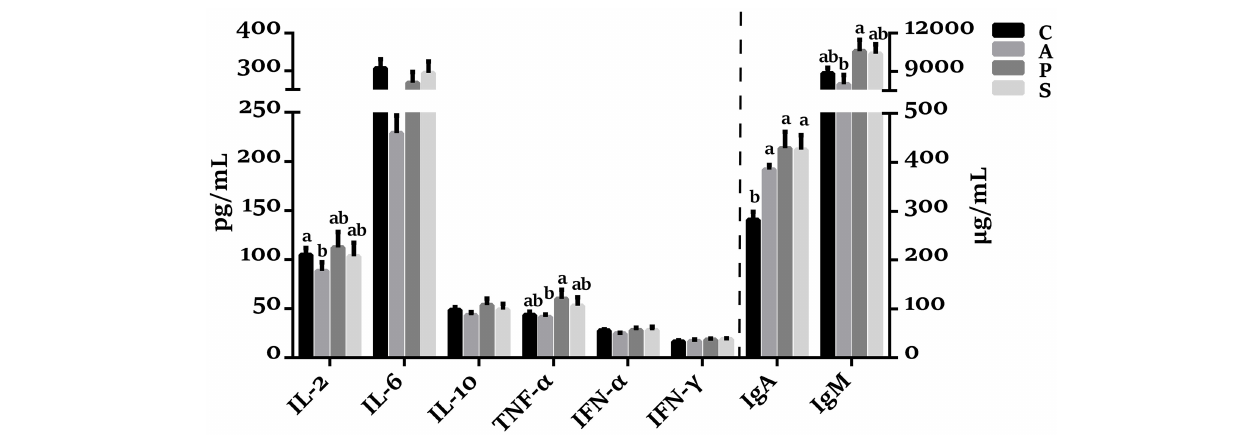
FIGURE 1 | Effects of maternal probiotic or synbiotic supplementation on the plasma cytokines concentrations of offspring piglets. Data are represented as means ± SEM, n = 8 per group. Different letters indicate significant differences among the groups ( P < 0.05). IL, Interleukin; TNF- α , Tumor necrosis factor-alpha; IFN, Interferon; IgA, immunoglobulin A; IgM, immunoglobulin M; C, control group; A, antibiotic group; P, probiotic group; and S, synbiotic group.